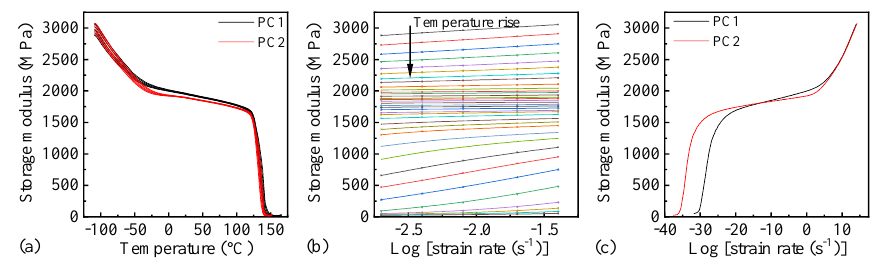
Fig. 1. (a) Storage modulus versus temperature at different frequencies, (b) Isotherms showing the dependence of modulus on frequency and temperature (PC1), (c) Time-temperature superposition